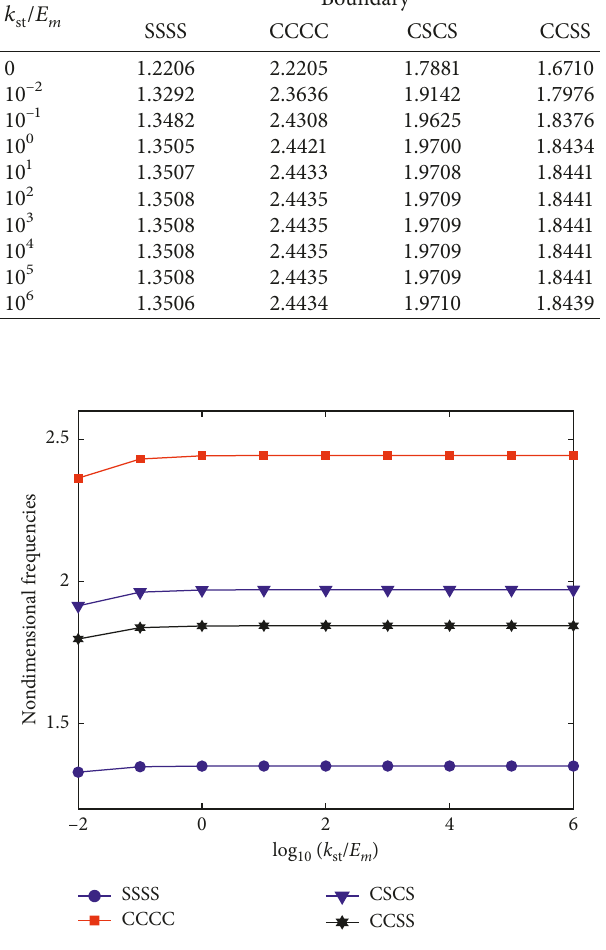
/ E m on nondimensional funda- st